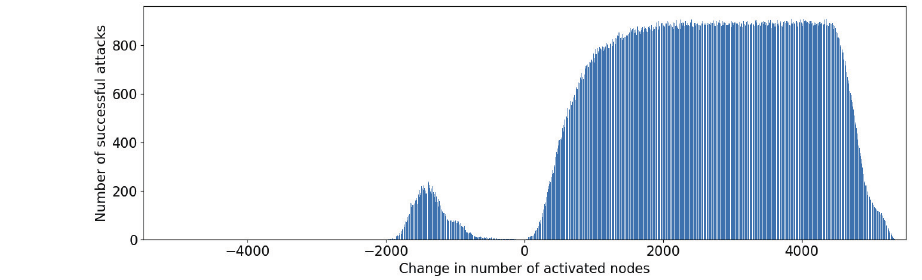
Figure 22: Simulation of relationship between the change in the number of all layers’ activated nodes and the number of successful attacks (misclassification) in the CNN